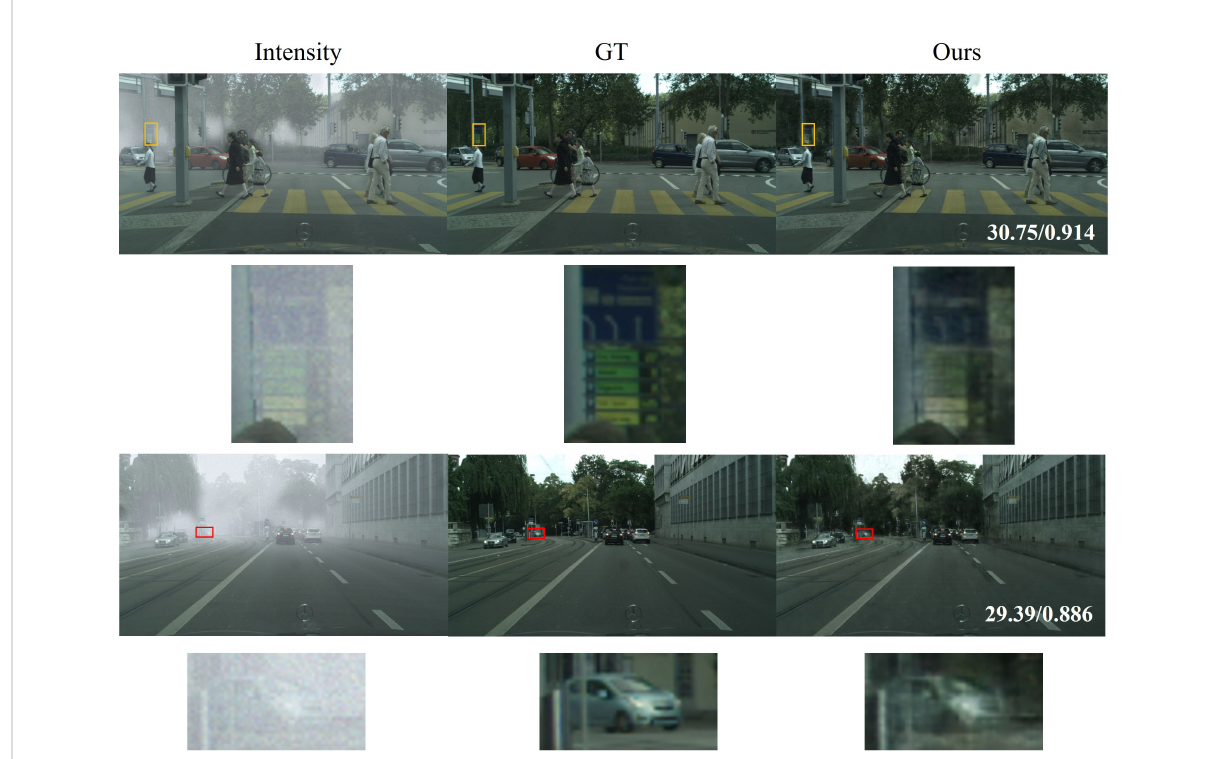
FIGURE 6 Visual de-scattering effects on Polarized Foggy Cityscapes-DBF dataset-Zurich. The numbers on the bottom-right corner of each image refer to its PSNR (dB) and SSIM. The bottom of each image represents the corresponding area in the rectangle frame. (1) and (2) are represented as two samples in the test